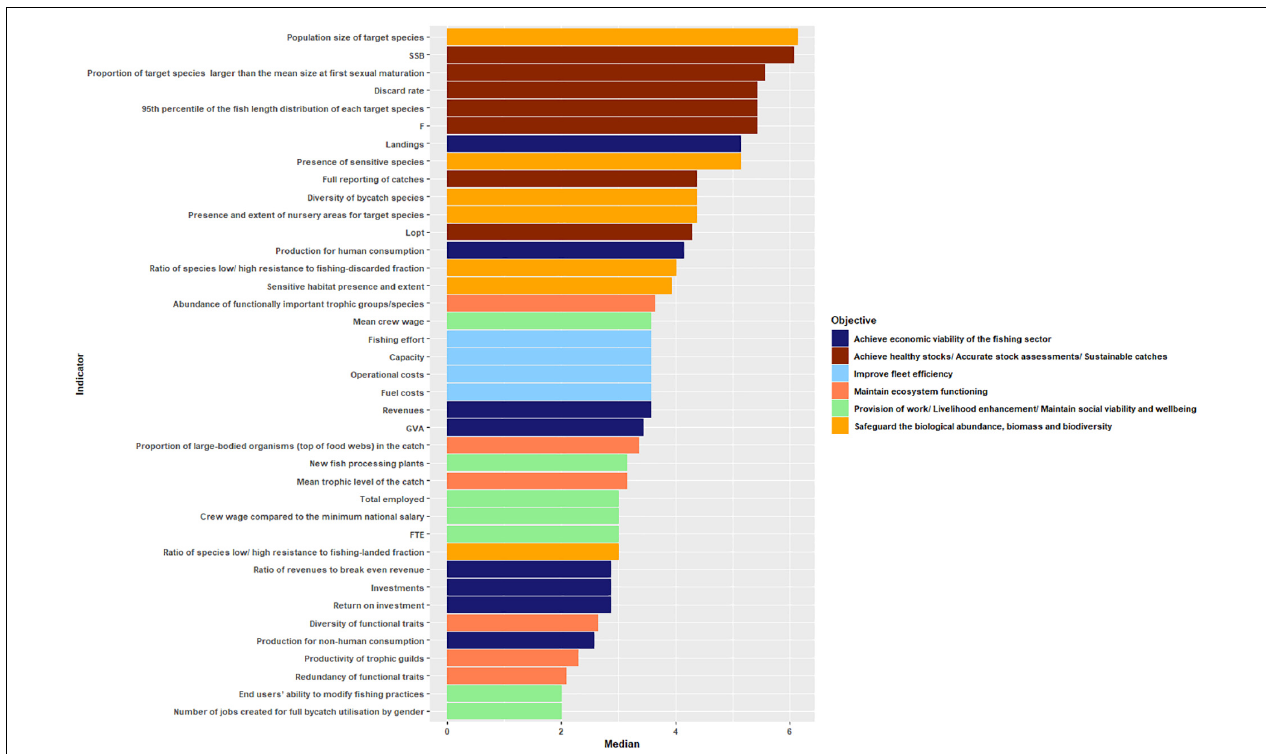
FIGURE 3 | Indicators’ quality score based on experts’ appraisal on 7 quality criteria and on the certainty of answers. F, Fishing mortality; SSB, Spawning Stock Biomass; Lopt, Optimum length; GVA, Gross value added; FTE, Full time equivalent. Bar color indicates framework